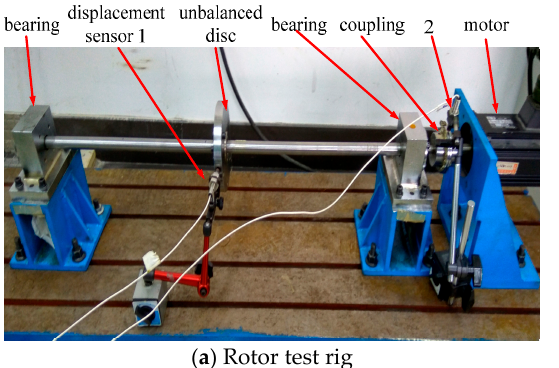
Figure 12. Test set up.